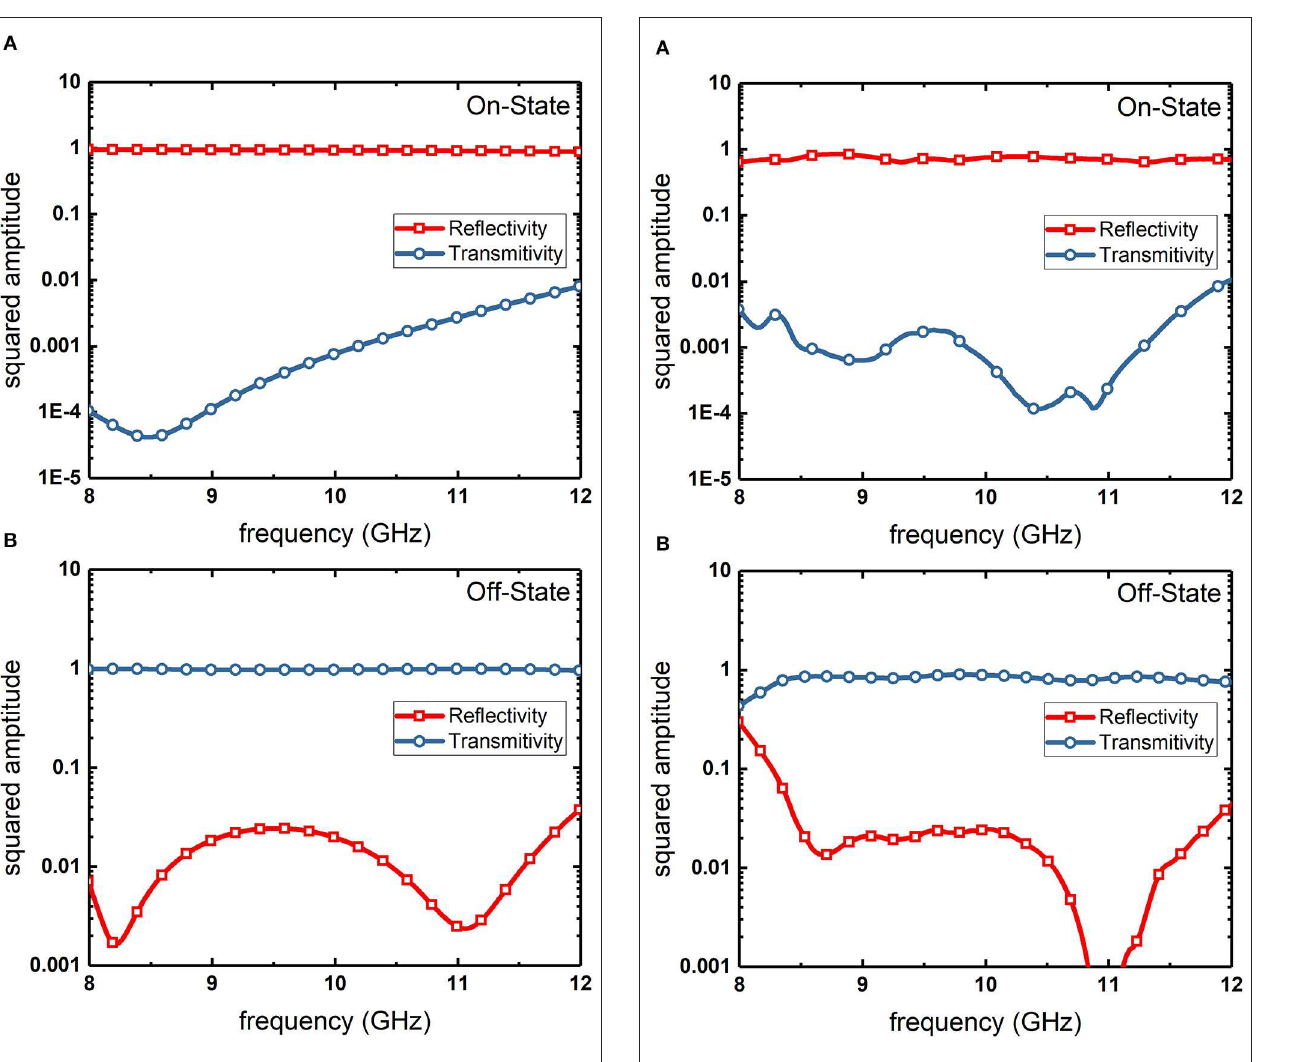
FIGURE 3 | The measured transmission (blue ring dot lines) and reflection (red square dot lines) spectra of the switchable metasurface when the loaded PIN diodes are (A) on-state and (B)